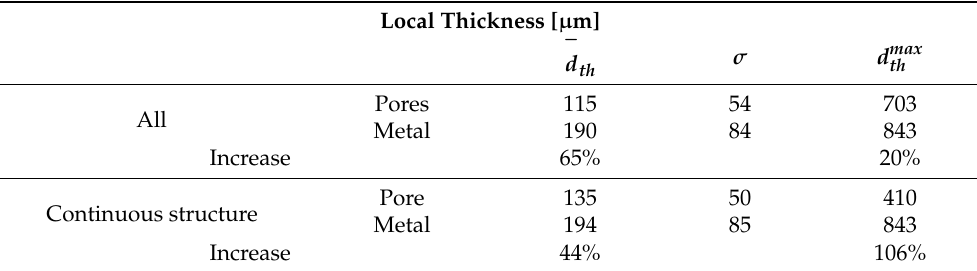
Table 3. Local thicknesses of the pores and metal inclusions: average local thickness d th , standard deviation, σ and maximum local thickness d max th